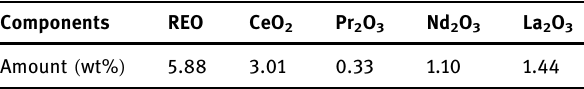
Table 2: Content of RE oxides in Bayan Obo mine